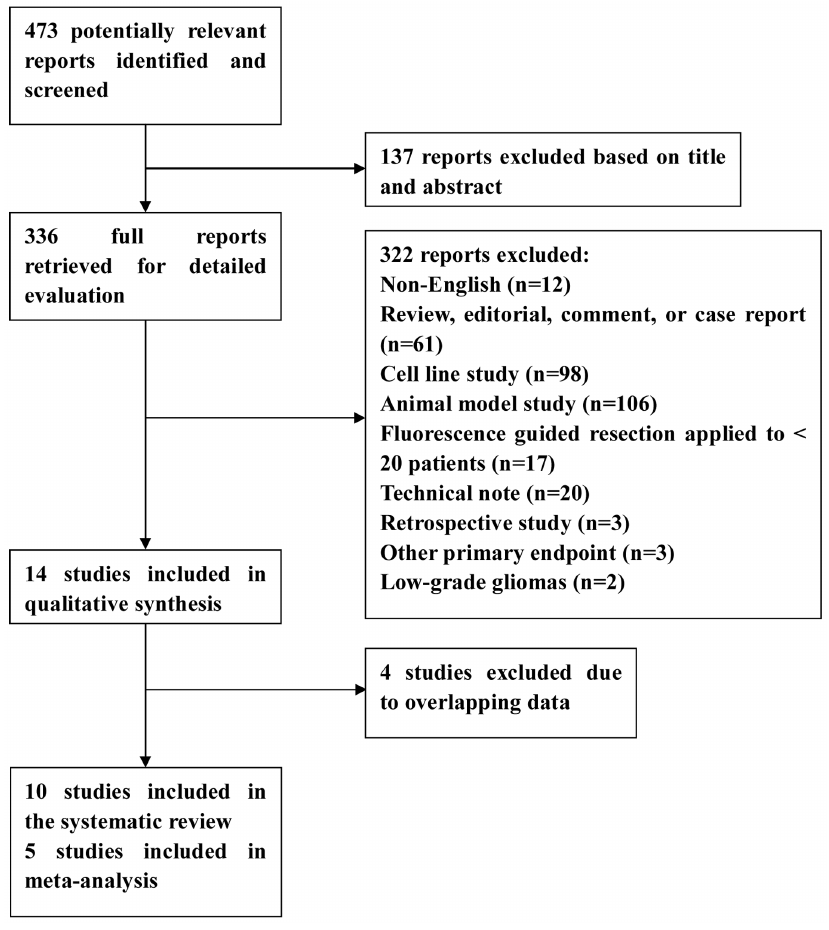
Figure 1. Flow diagram outlining the study selection process.